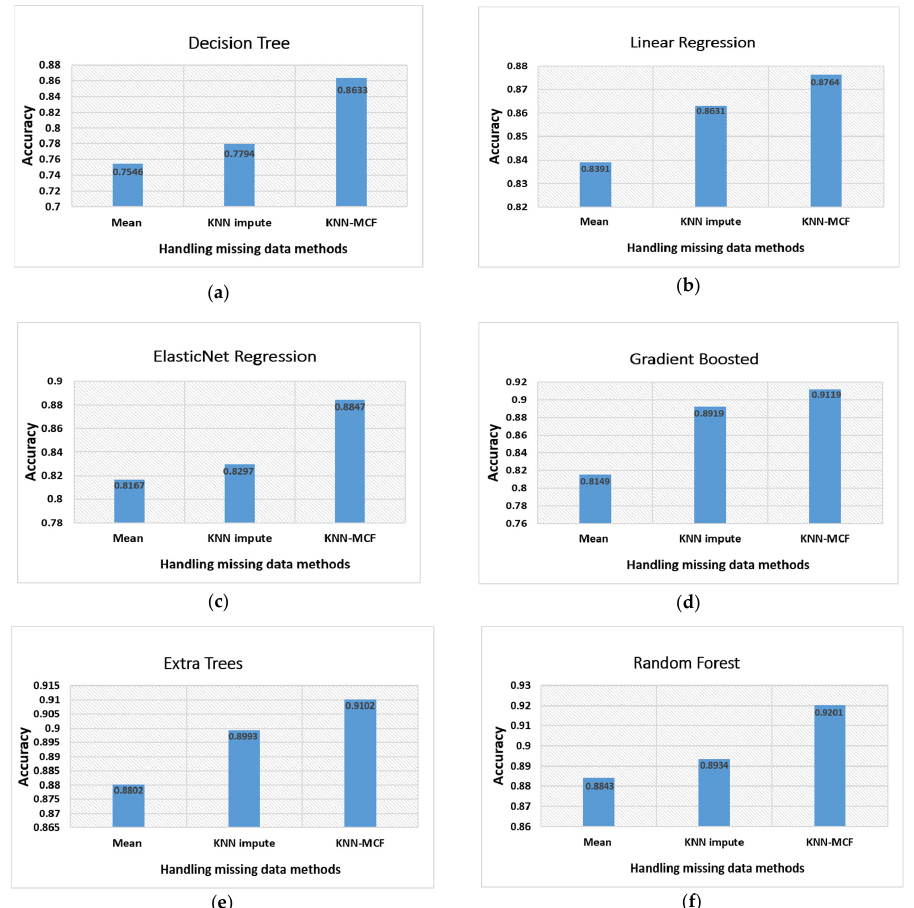
Figure 4. Comparison of the accuracy of the mean, KNN impute, and K-nearest neighbor algorithm based on the most correlated features (KNN–MCF) methods for dealing with missing data with that of several machine learning algorithms: ( a ) decision tree, ( b ) linear regression, ( c ) ElasticNet, ( d ) extra trees, ( e ) gradient boosted, and ( f ) random forest.